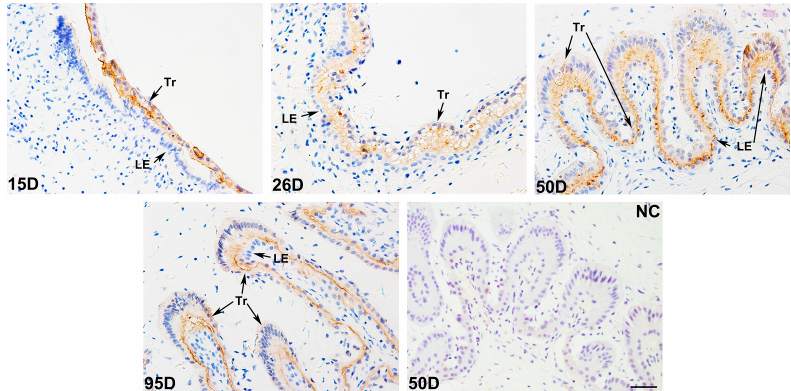
Figure 2. Immunohistochemical analysis of PLET1 at the maternal-fetal interface in pigs on Days 15, 26, 50, and 95 of gestation. The positive signals of PLET1 were only detected in Tr. The section stained with isotype matched normal rabbit IgG was used as the negative control. Legend: D: day of gestation. Tr: trophoblast cells; LE: luminal epithelium; NC: negative control. Scale bar = 40 μ m.